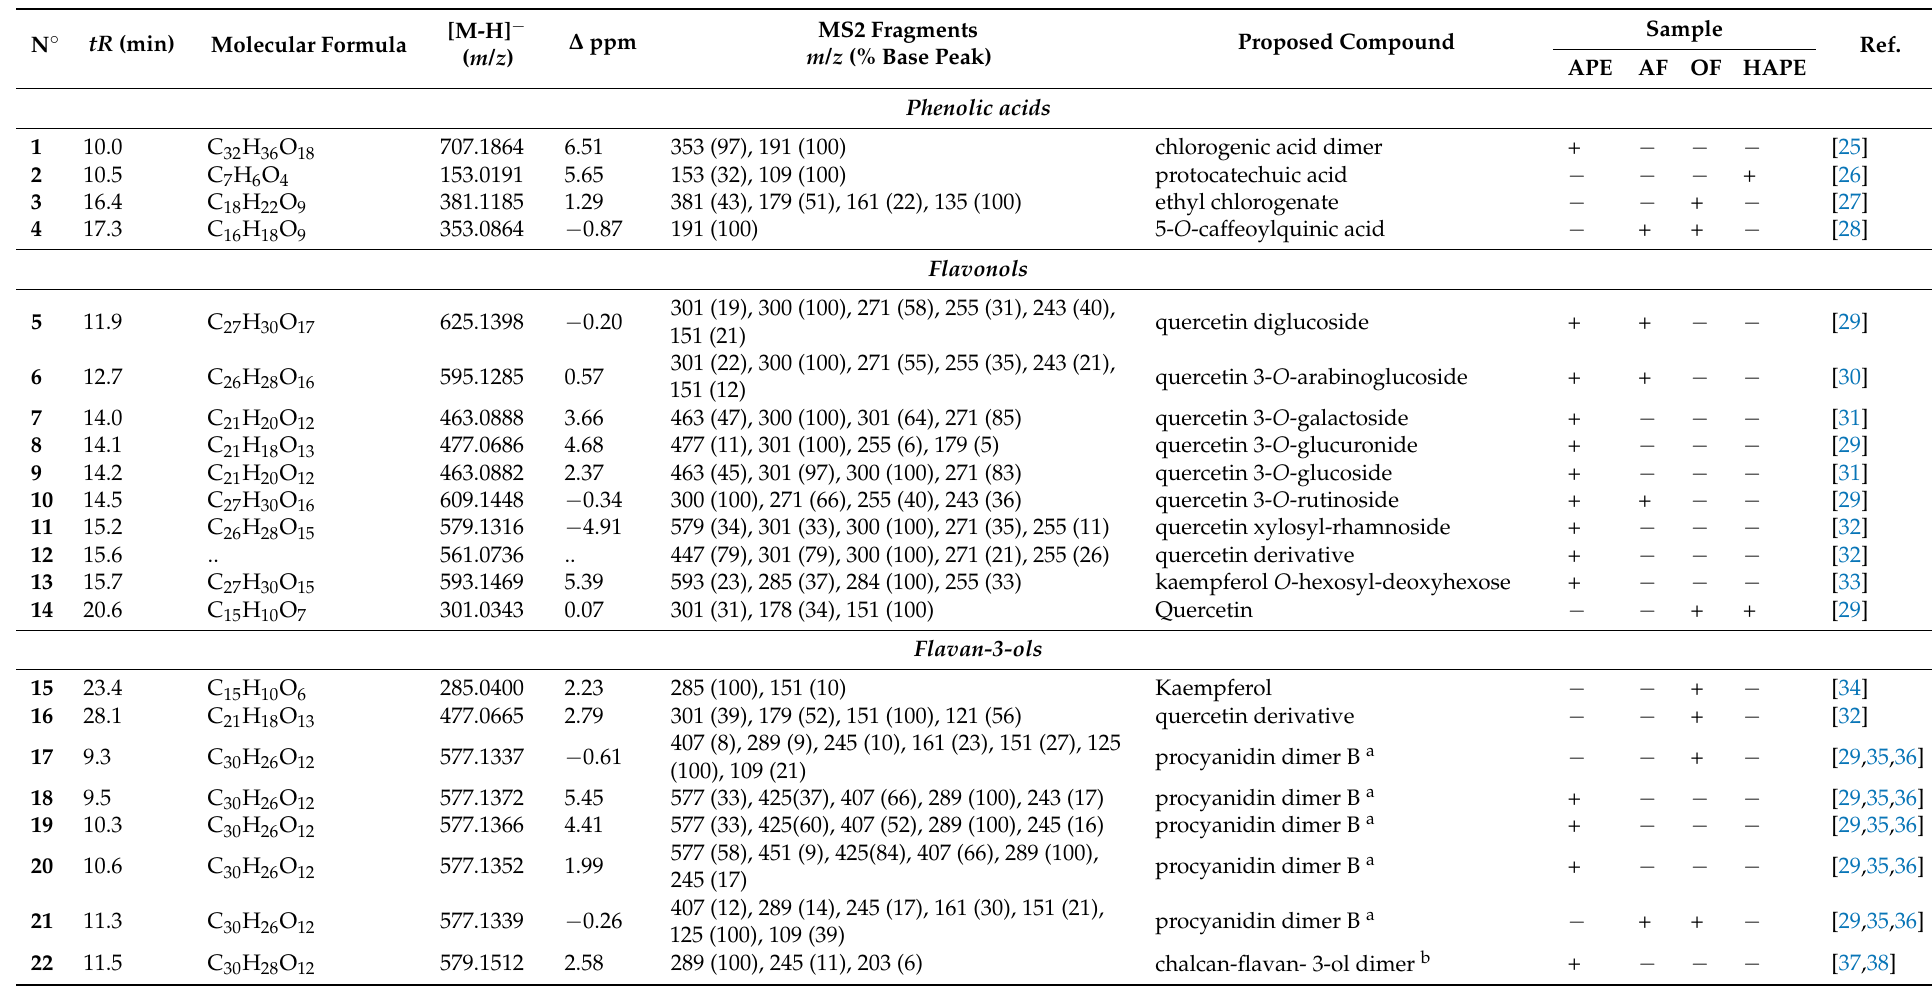
Table 1. High-resolution mass spectrometry (MS) data and negative ion MS 2 fragmentation of compounds characterized in avocado peel extract (APE), the aqueous fraction (AF), the organic fraction (OF), and the organic fraction of acid-microwave hydrolyzed avocado peel extract (HAPE) N ◦ tR (min) Molecular Formula Proposed Compound